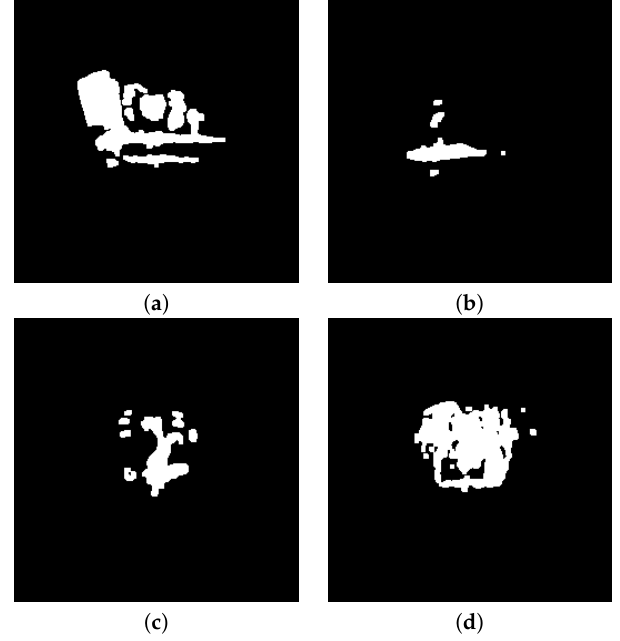
Figure 21. Segmented acquisitions, large angle: ( a ) gun, ( b ) knife, ( c ) keys, ( d )